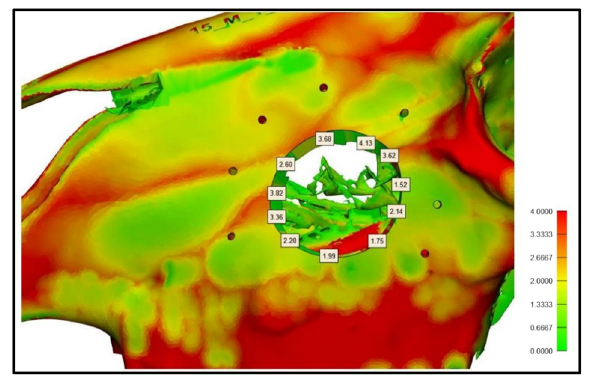
Fig. 8 Preoperative virtual planning of the future defect in the anterior wall of the maxillary sinus; Heatmap showing the average thickness of the bone in